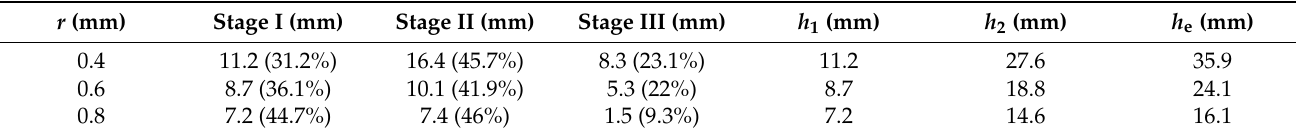
Figure 6. Comparison of analytic solutions with experimental results of this study (water in a capillary tube with r = 0.4 mm). The variable value of cos θ , as extracted from Equation (6), was used. Table 1. Lengths of characteristic stages including percentages of corresponding stages and their end positions for DW with different capillary tube